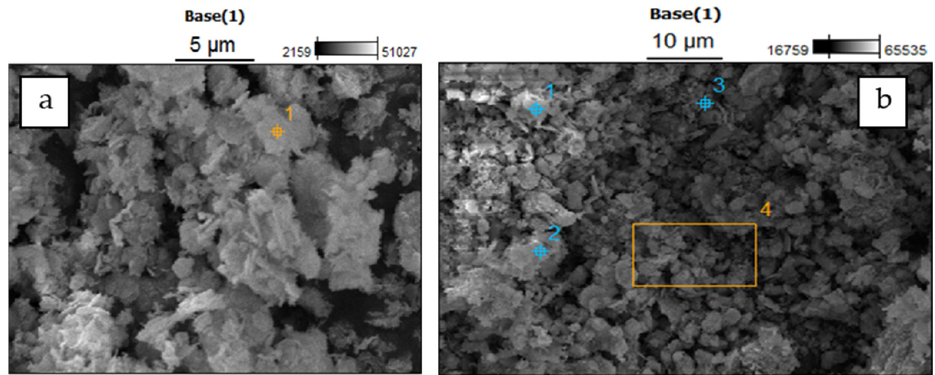
Figure 5. SEM Images of Red Soil 1 Before ( a ) and After ( b ) Adsorbing Arsenate.